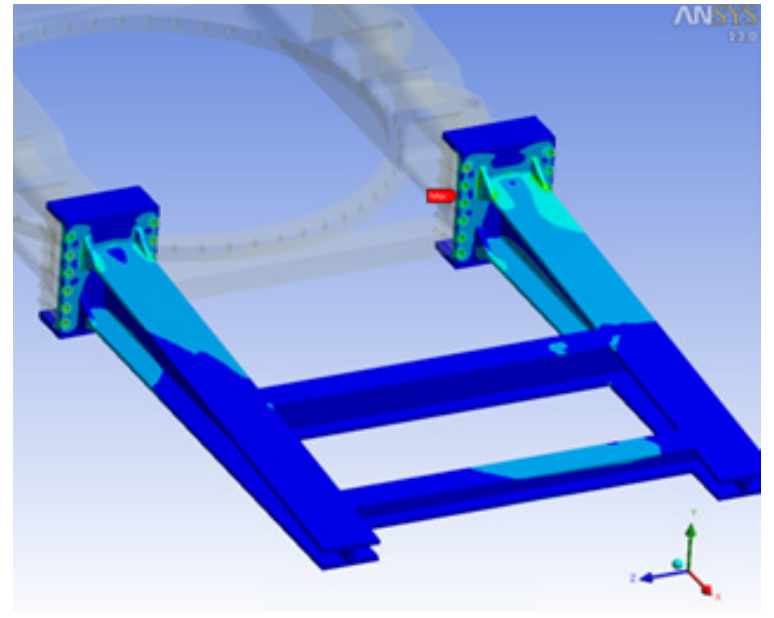
Figure 10. Maximum stress on profile part [30].